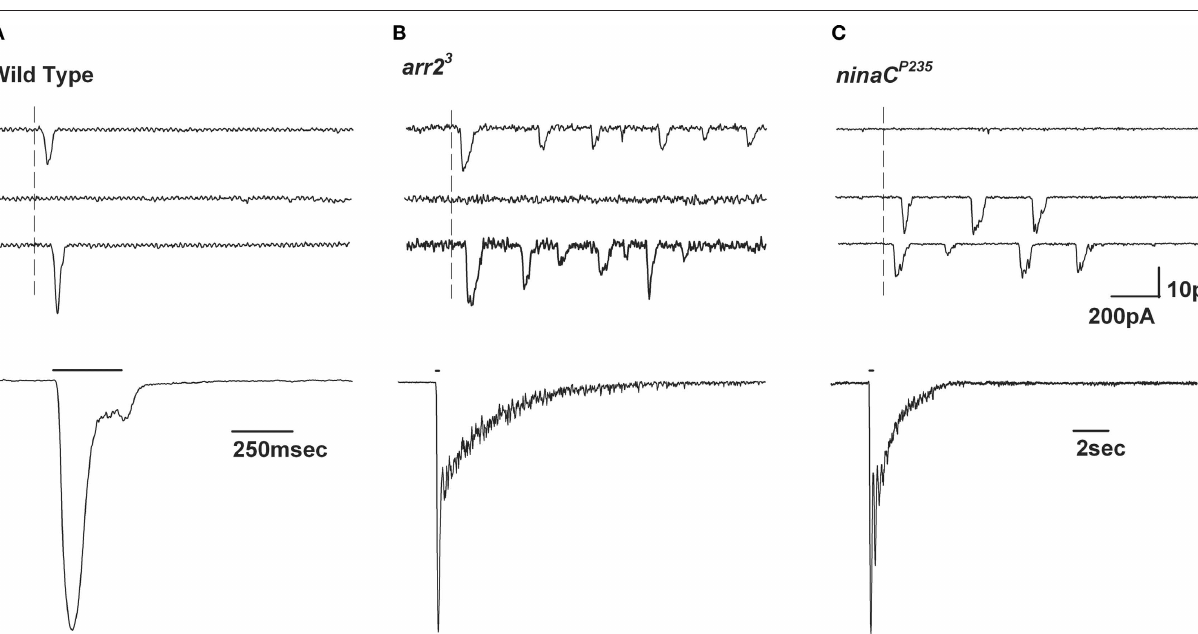
FIGURE 5 | Slow response termination in arr2 and ninaC null mutants. (A–C) Upper panels: Whole-cell voltage clamp recordings of quantum bumps in response to brief (1 ms) dim fl ashes of light with intensity suffi cient to activate only a single rhodopsin molecule upon photon absorption in wild-type (WT), arr2 3 and ninaC P235 null Drosophila mutant fl ies. In WT, only a single bump is induced by a single fl ash and some fl ashes do not elicit any bump